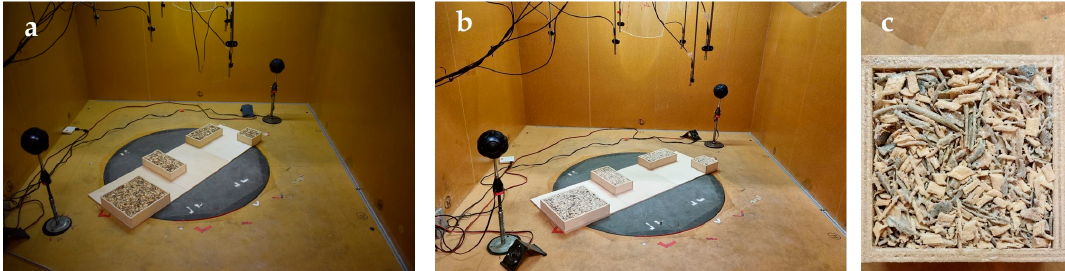
Figure 9. ( a ) B full,2 configuration; ( b ) B full,2 configuration with a spray film coating; ( c ) details of the sprayed surface.